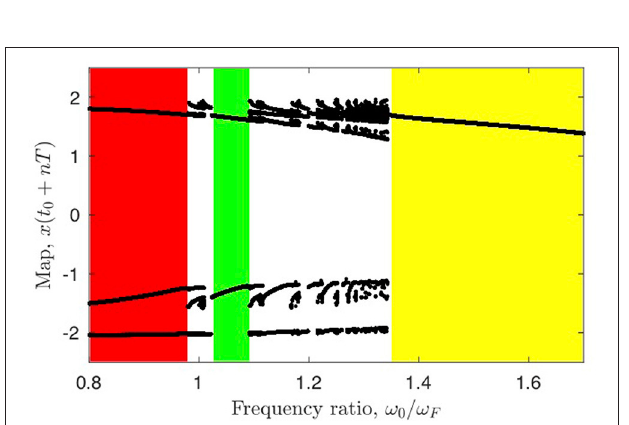
FIGURE 7 | The response of the van der Pol oscillator (3) as a function of the forcing amplitude A and the parameter α . The oscillator frequency ω synchronizes in rational ratio to the forcing frequency ω F . The colored patches of synchronization are called Arnold tongues. The ordinate is ω 0 ( α ) /ω F , obtained by calculating ω 0 for A = 0 as a function of α . The parameter γ is kept fixed at γ = 5. The arrow with time ticks indicates the change corresponding to the change of α through the MPT shown in Figure 8